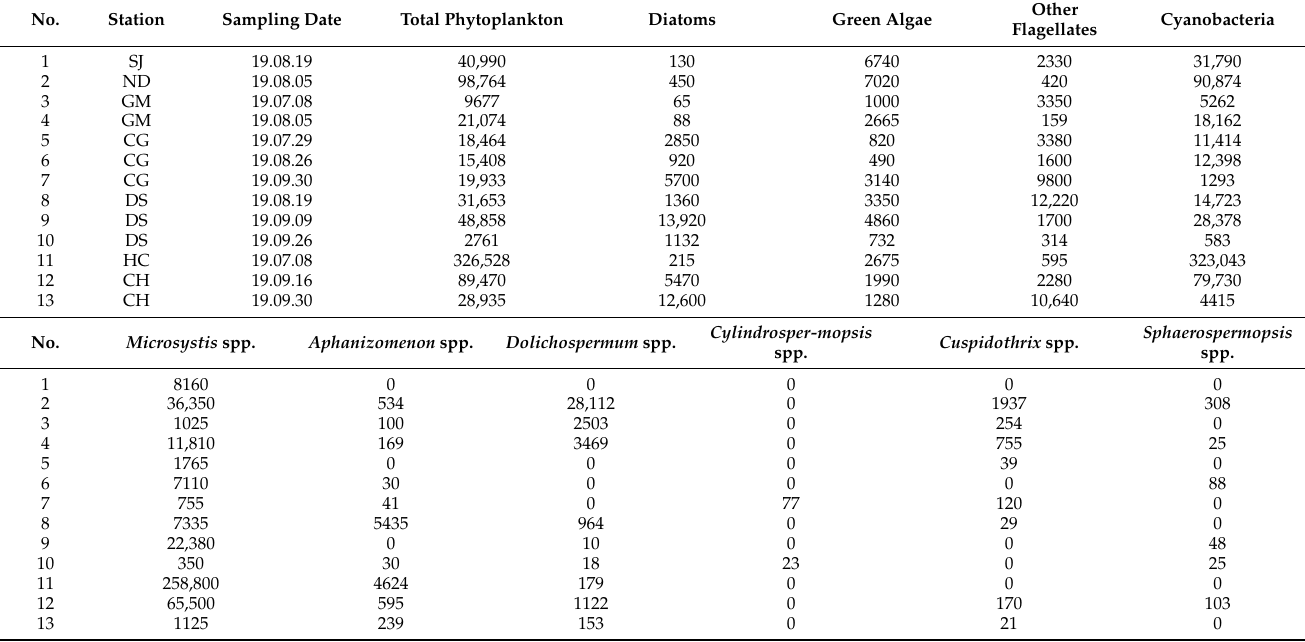
Table 4. Community structure of the phytoplankton in field samples (cells · mL − 1 ); cell densities of total phytoplankton and major groups (upper) and cyanobacterial genera